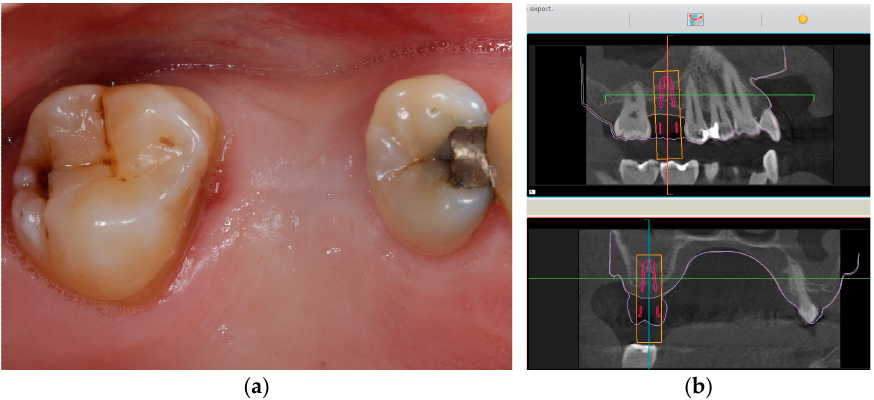
Figure 1. Initial clinical situation at baseline. ( a ) Initial situation from occlusal aspect before